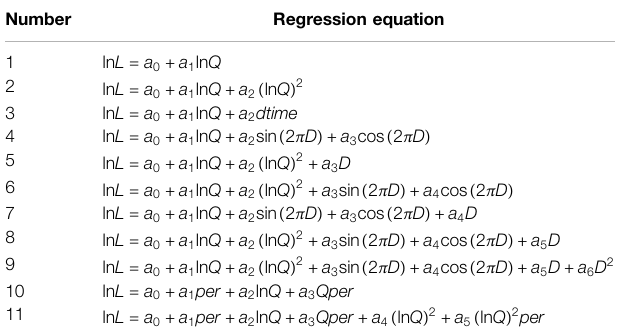
TABLE 1 | Regression equations to determine the river pollutant fl ux by the LOADEST model.